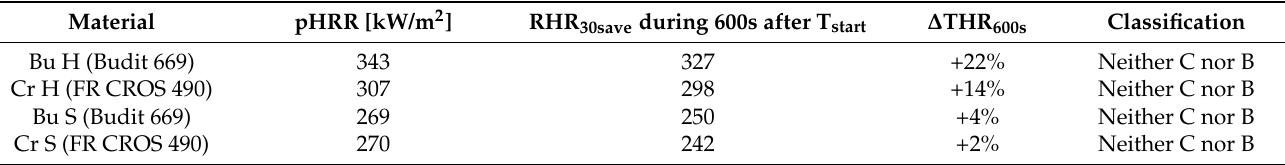
Table 5. Results for pHRR, RHR 30save and for the increase of the total heat release (THR 600s ) after artificial weathering for 28 days. Classification of the results for hollow-chamber (H) and solid profiles (S) according to ETAG 028 (2012).